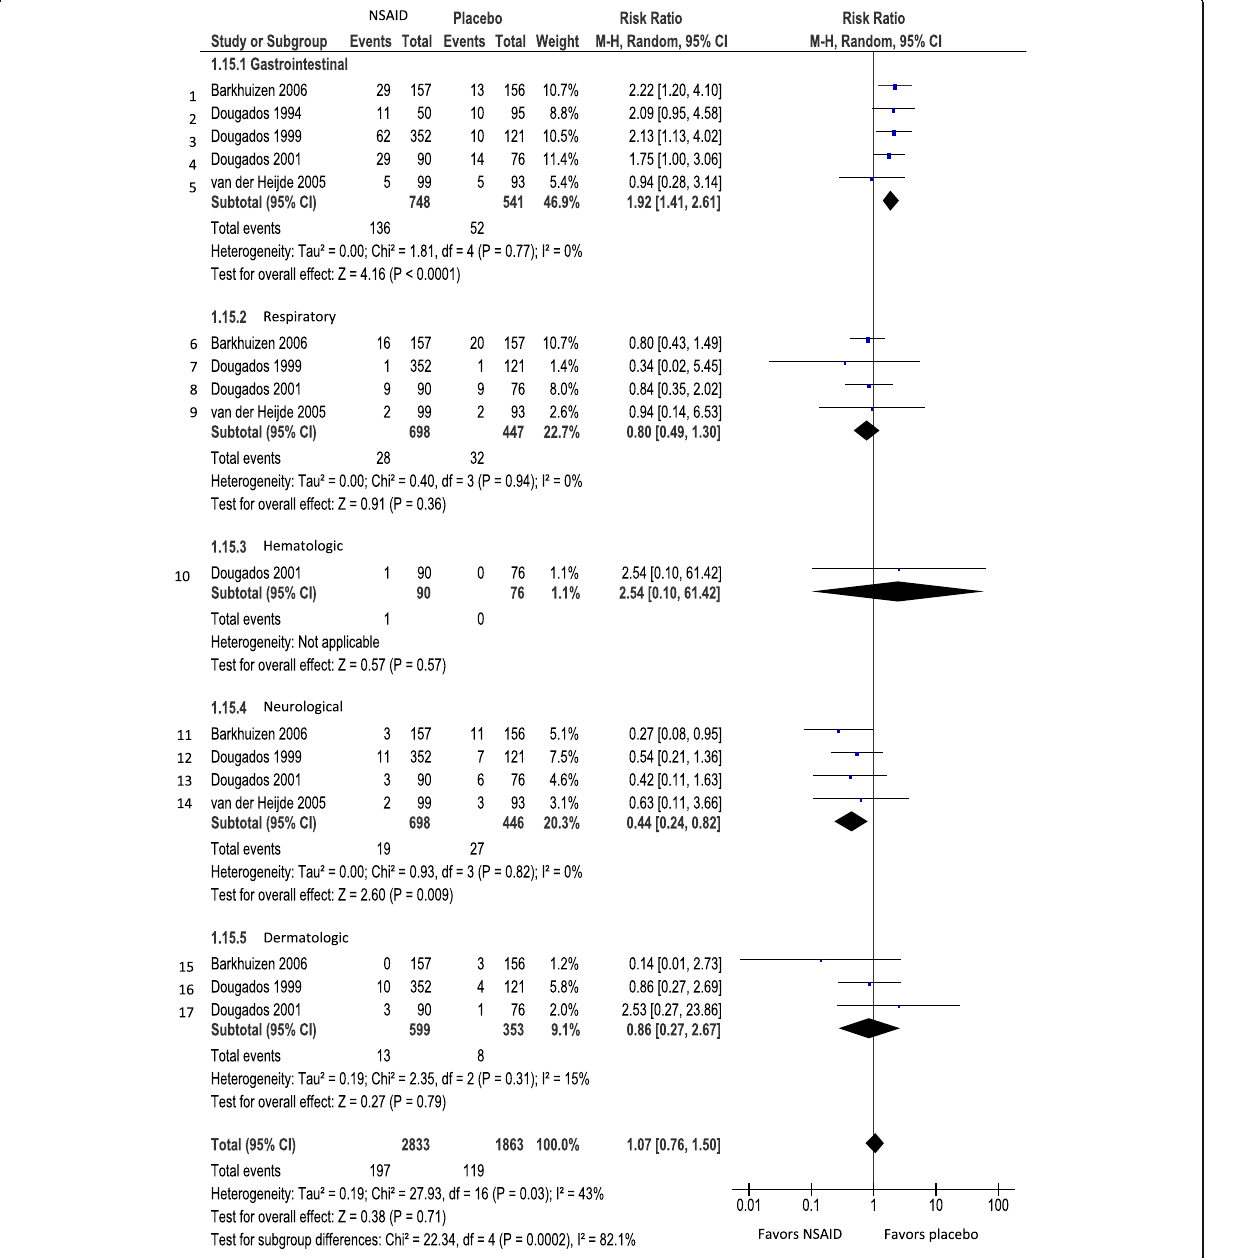
the observation time) [23]. Another Taiwan case-control study found negative association between the use of cele- coxib (versus non-users) and coronary events [OR=0.34 (95% CI 0.13 to 0.89)] in AS patients [26]. Other publications